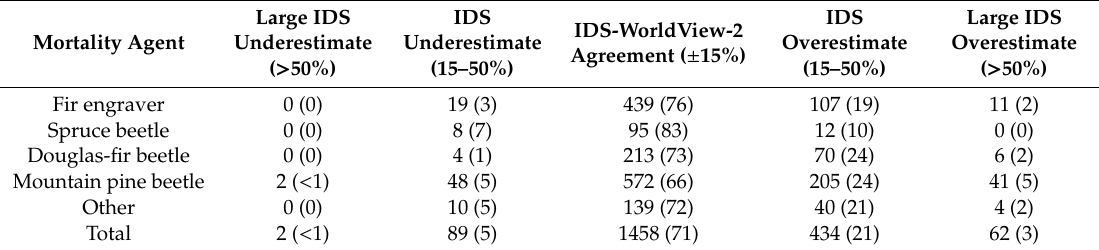
Table 6. Severity estimation accuracy of IDS polygons by mortality agent using the Meddens Overall accuracy = 71.3%.